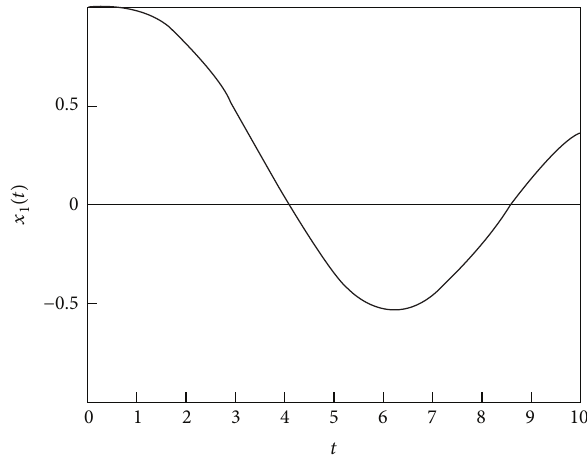
Figure 1: Comparison of the solution computed through the symbolic method presented in this paper, and the numeric solution to the problem calculated by a Runge-Kutta fourth order method with a step of ℎ = 0.001